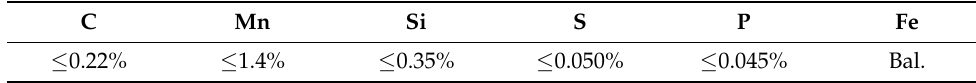
Table 1. Chemical composition of Q235 substrate (wt.%). C Mn Si